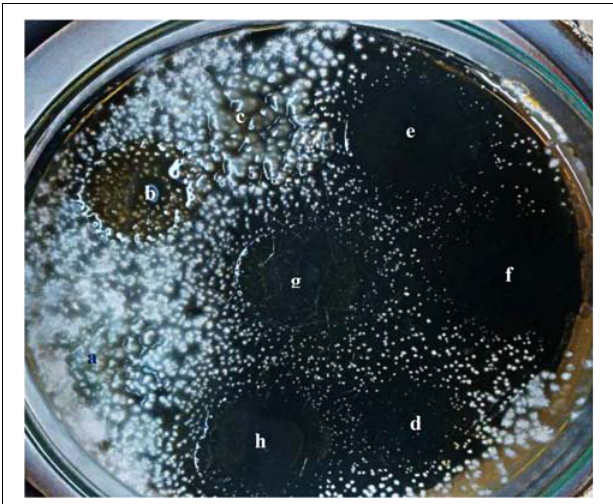
FIGURE 4 | Antifungal activity of miconazole-containing film in the absence and presence of urea showing inhibited growth of T. rubrum around the films after 14 days of incubation at room temperature. (a) Placebo film, (b) miconazole containing film M, (c) 20% urea U20, (d) combination of miconazole and urea (M + U10), (e,f) combination of M + U20, (g,h) combination of M + U40.